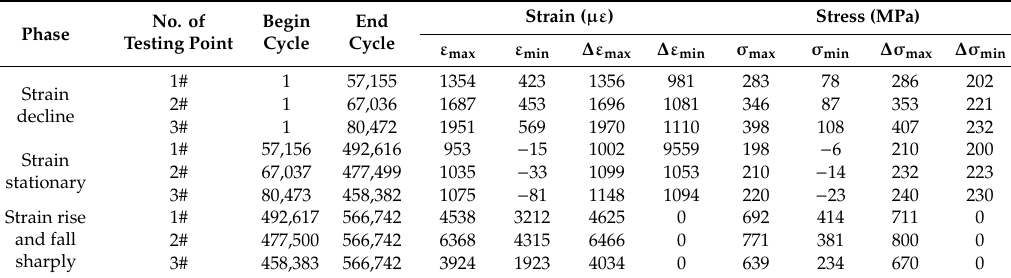
Table 6. Key parameters of the stress-strain